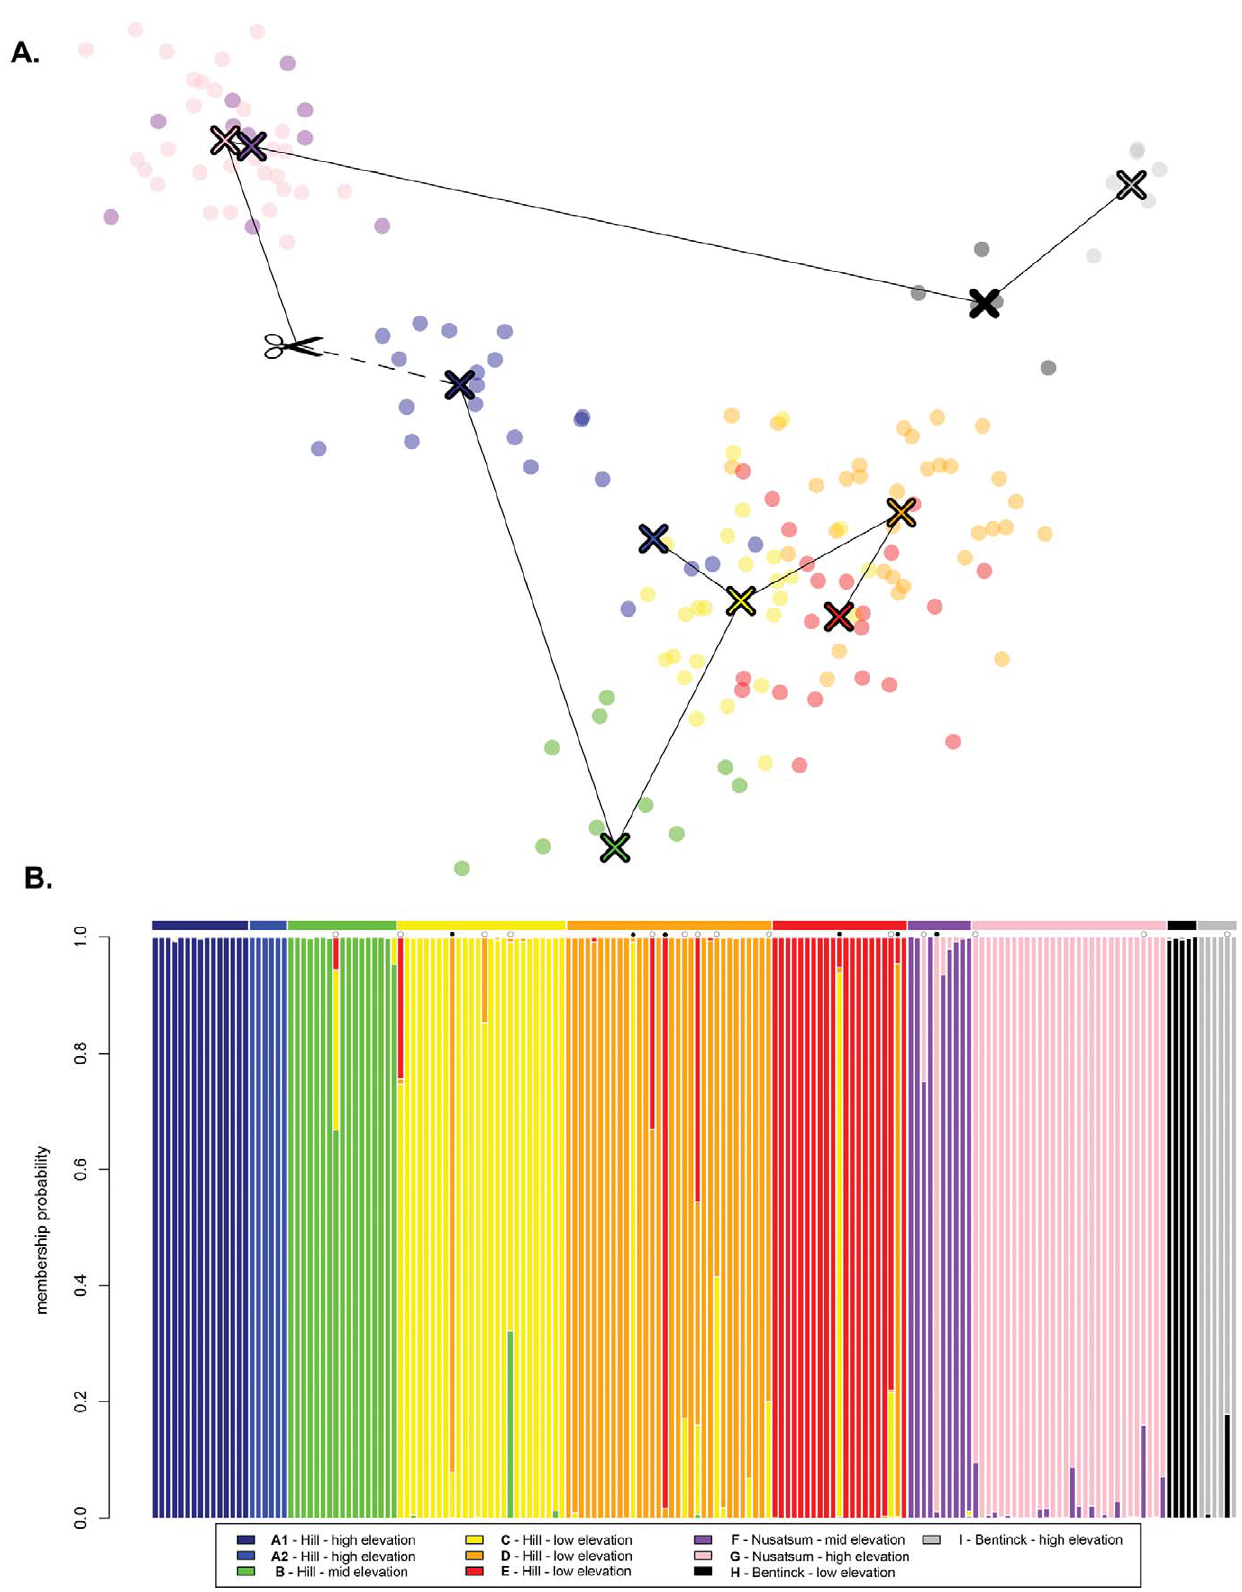
Figure 2. Population structure in pikas from the Bella Coola Valley. A. Scatter plot from the Discriminant Analysis of Principal Components (DAPC) [23] with a minimum spanning tree based on the squared distance between populations, showing the regional cohesion of sample sites into clusters that represent the three elevation gradients sampled. The centre of each group is indicated by a cross of the respective colour. Note that the